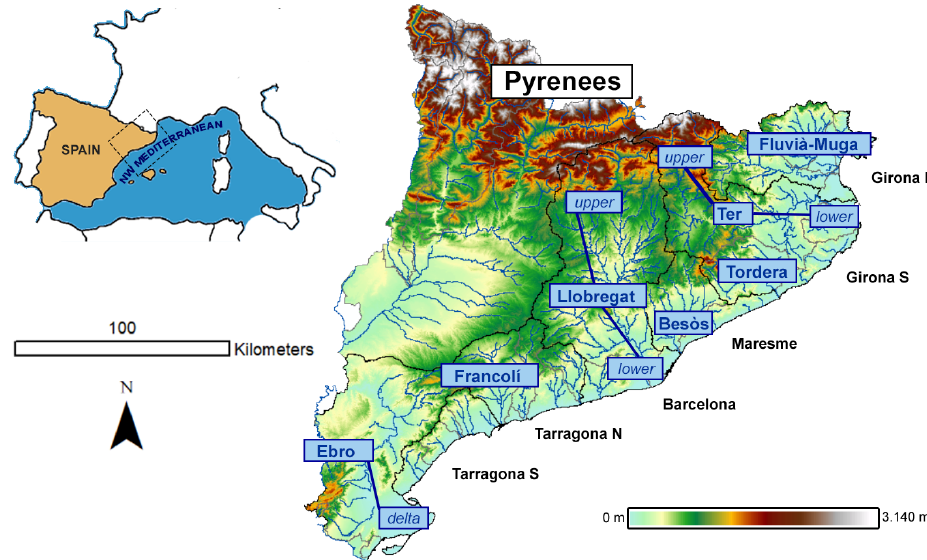
Figure 1. Study area and main coastal river systems. Digital elevation model 15m × 15m by Institut Cartogràfic and Geològic de Catalunya